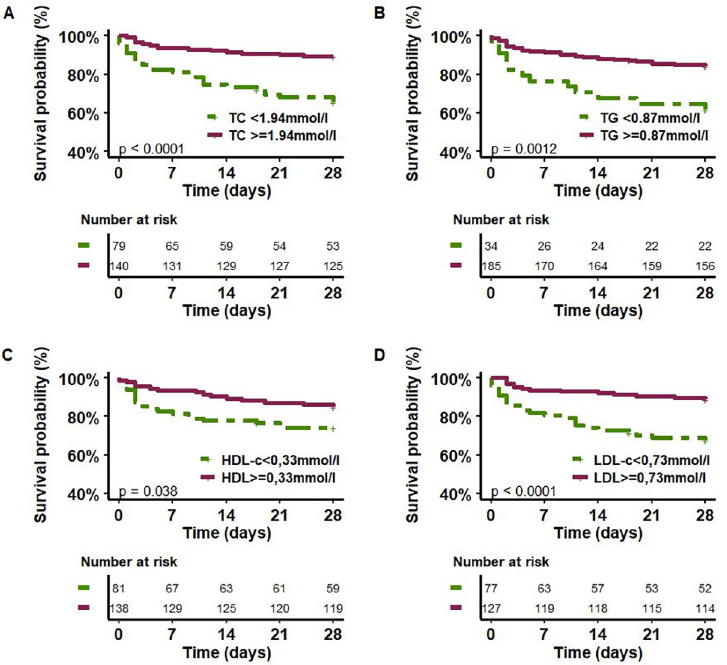
Fig 3. Kaplan–Meier estimates of survival in the 28 days after the onset of sepsis for patients with different initial levels of lipoproteins. TC: total cholesterol, HDL-C: high-density lipoprotein-cholesterol, LDL: low-density lipoprotein-cholesterol, TG: triglycerides.